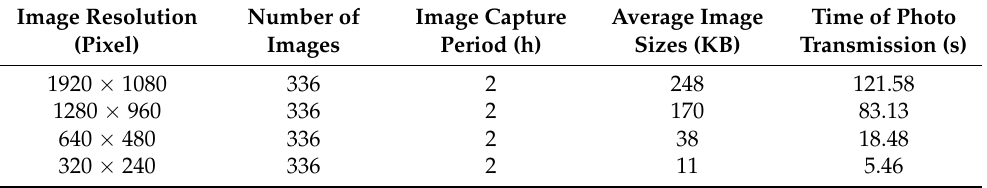
Table 1. Average image size and time of image transmission for different image